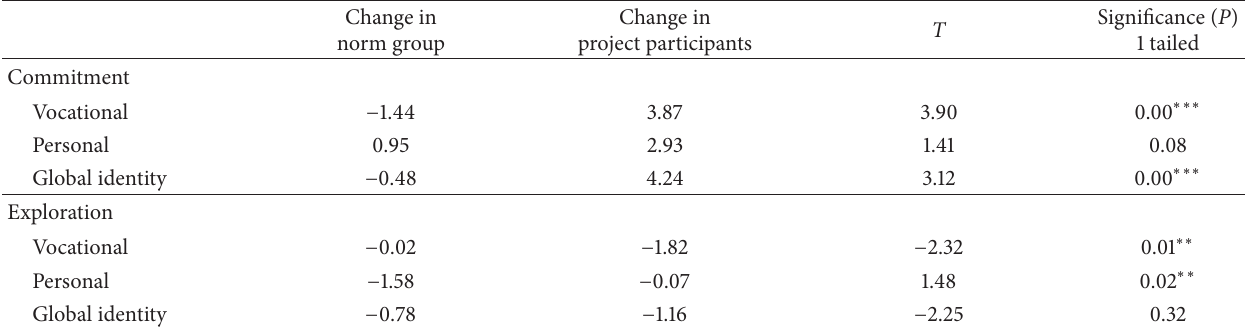
Table 4: Comparison of change in norm group and in project participants’ group.